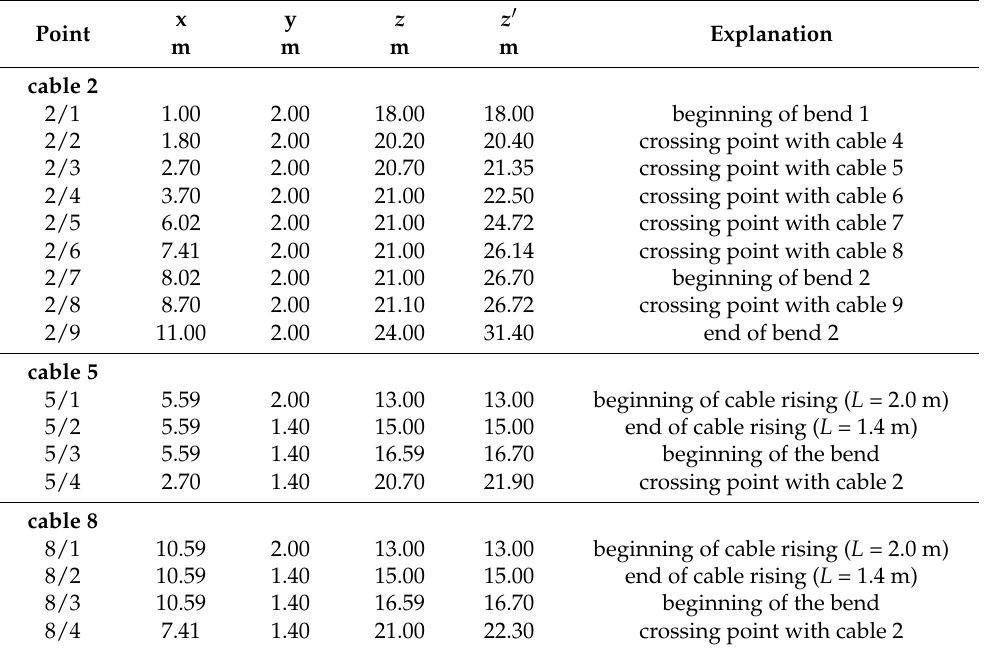
Table 1. Explanations of the special points in Figure